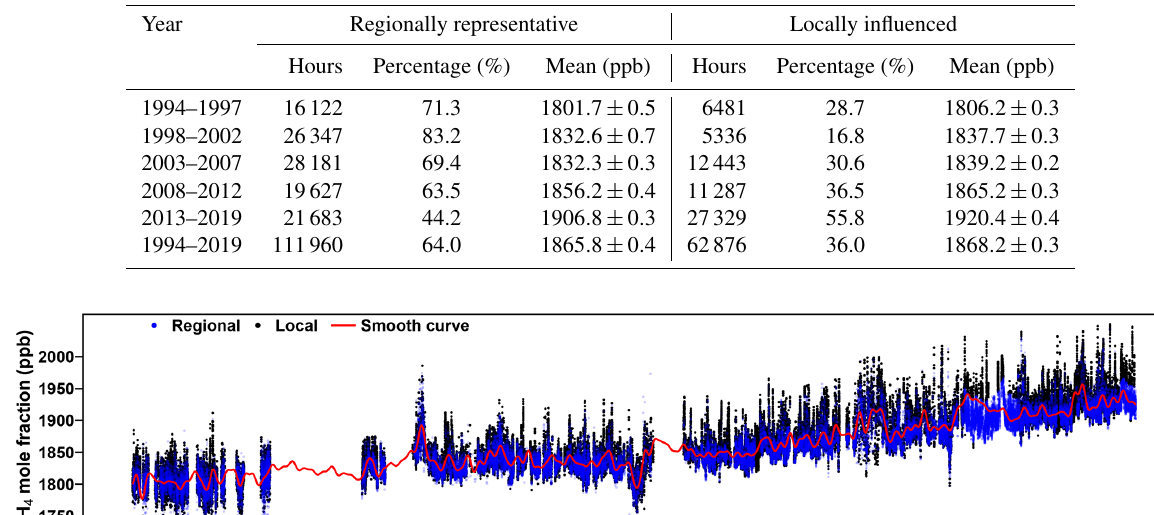
Table 1. The statistics of the filtered CH 4 data series over different periods during 1994–2019 at the WLG station. Note: ppb – parts per billion.